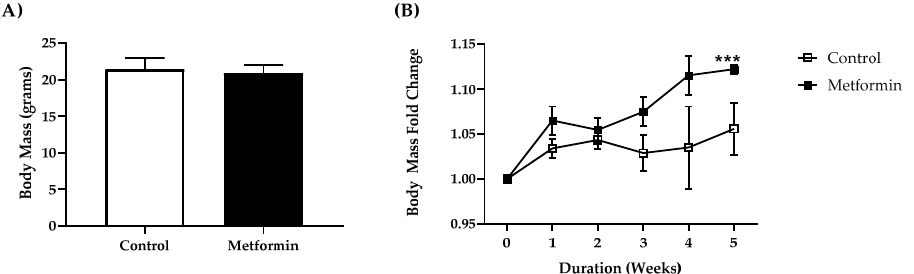
Figure 2. Body weight in C57BL/6J male and female mice following orthotopic LL/2 non-small lung cancer cell implantation. ( A ) Body mass (grams) between control and treatment mice. ( B ) Body mass fold change between control and metformin- (250 mg/kg) treated mice following orthotopic LL/2 cancer cell implantation. Data were analyzed using mixed modeling (time × treatment). *** p < 0.001, main effect for time. Control, n = 7; metformin, n = 9. Data shown as mean ± SEM.